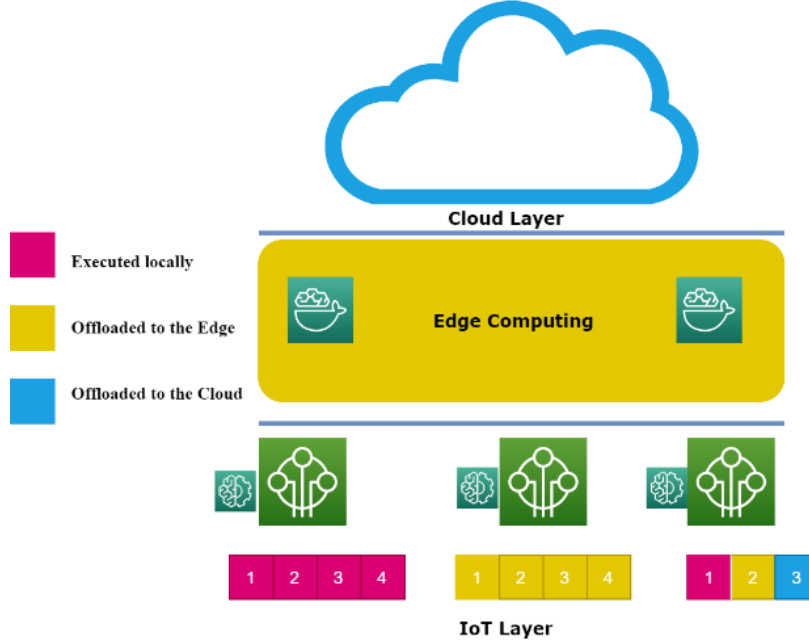
Figure 1. Using multiple layers and networks to offload different aspects of tasks.